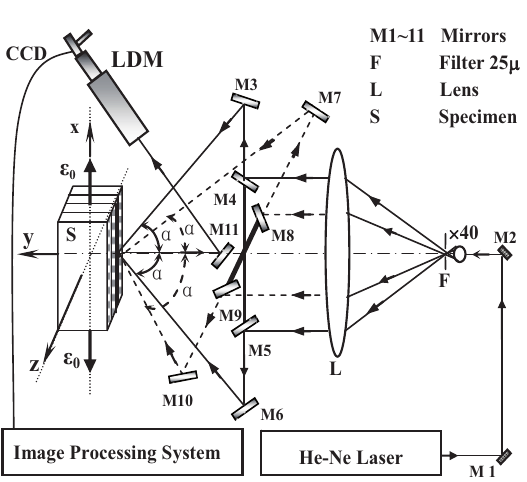
Fig. 3 Optical paths and arrangement for LDM four-beam moiré